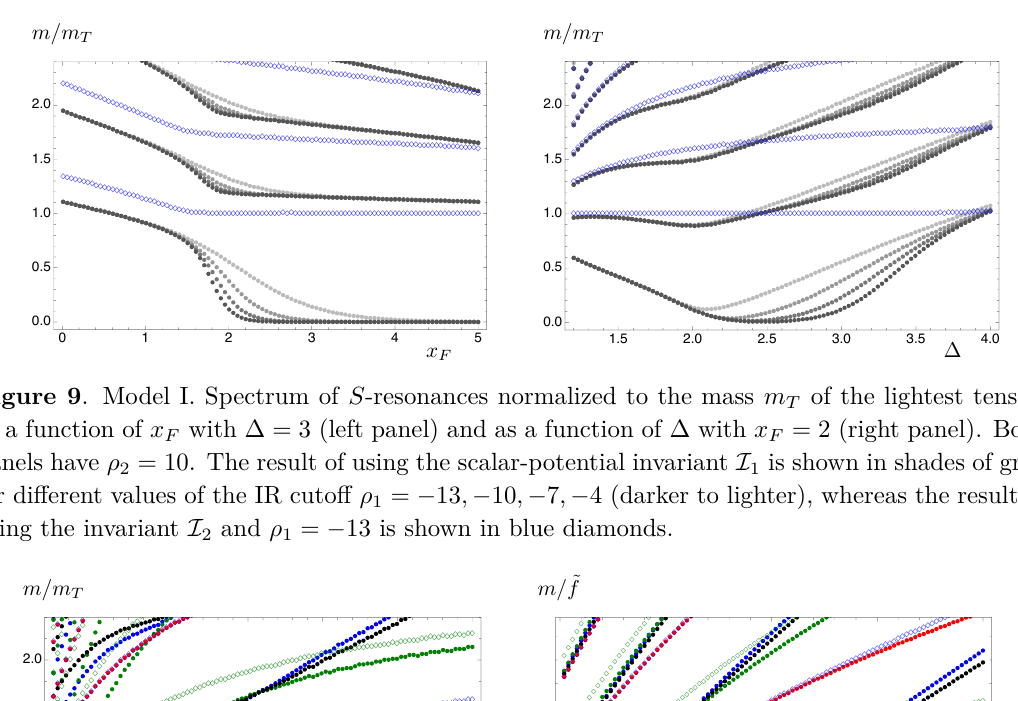
= 2 (right panel). Both F is shown in shades of gray 1